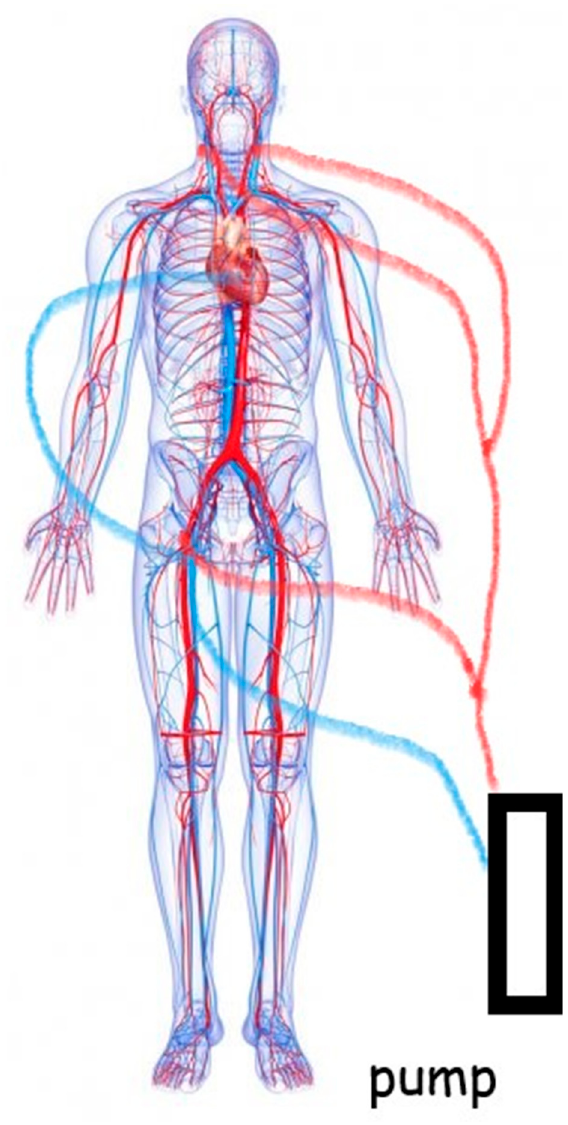
Figure 4. Completion of the cardiopulmonary bypass circuit with the three-way arterial cannulation approach. The red lines represent the arterial configuration. The blue lines show the venous configuration with an extension should cannulation of the superior vena cava be required for further drainage.